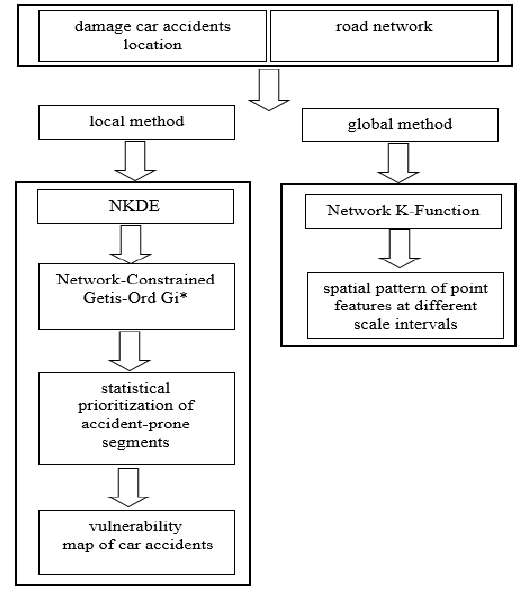
Figure 2. Flowchart of the proposed method for car accidents